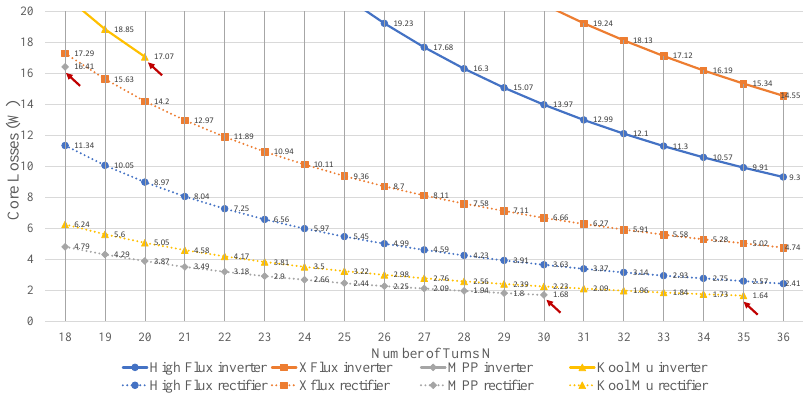
Figure 6. Core losses comparison of the inductors of the rectifier and inverter for four materials as a function of number of turns. The arrows indicate an occurrence of core